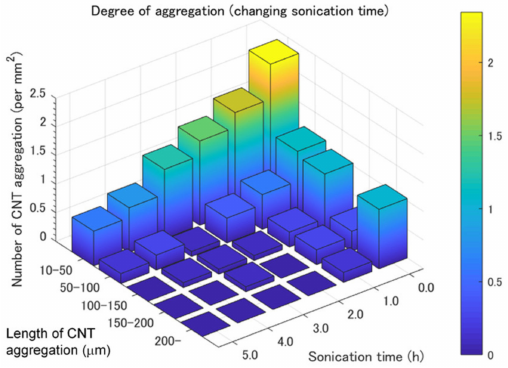
Figure 5. Influence of sonication time on CNT dispersion states (1.0 mass.% CNT / Al